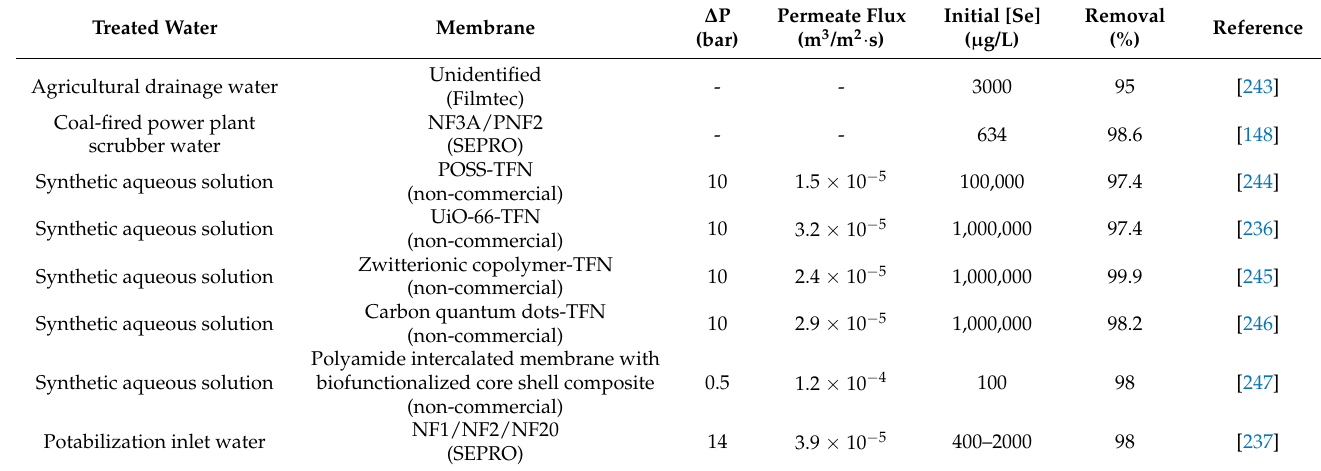
Table 9. Examples of application of nanofiltration for selenium removal from